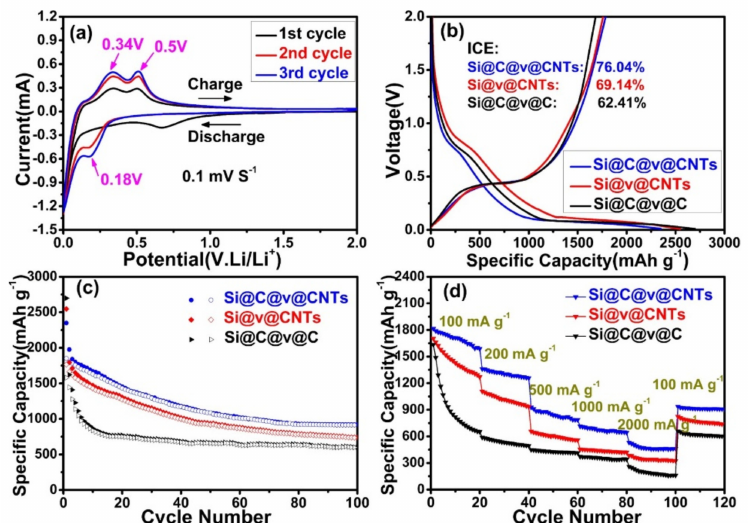
Figure 4. Electrochemical properties: cyclic voltammetry for the first three cycles of Si@C@v@CNTs at a scan rate of 0.1 mV s − 1 between 0–2.0 V ( a ), the initial discharge–charge curves at 100 mA g − 1 ( b ), cycling performances at 100 mA g − 1 ( c ), the rate performances ( d ) of Si@C@v@C,